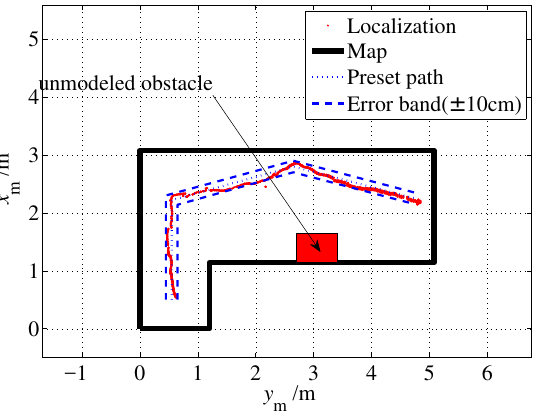
Figure 22. Localization result (with an unmodeled obstacle).